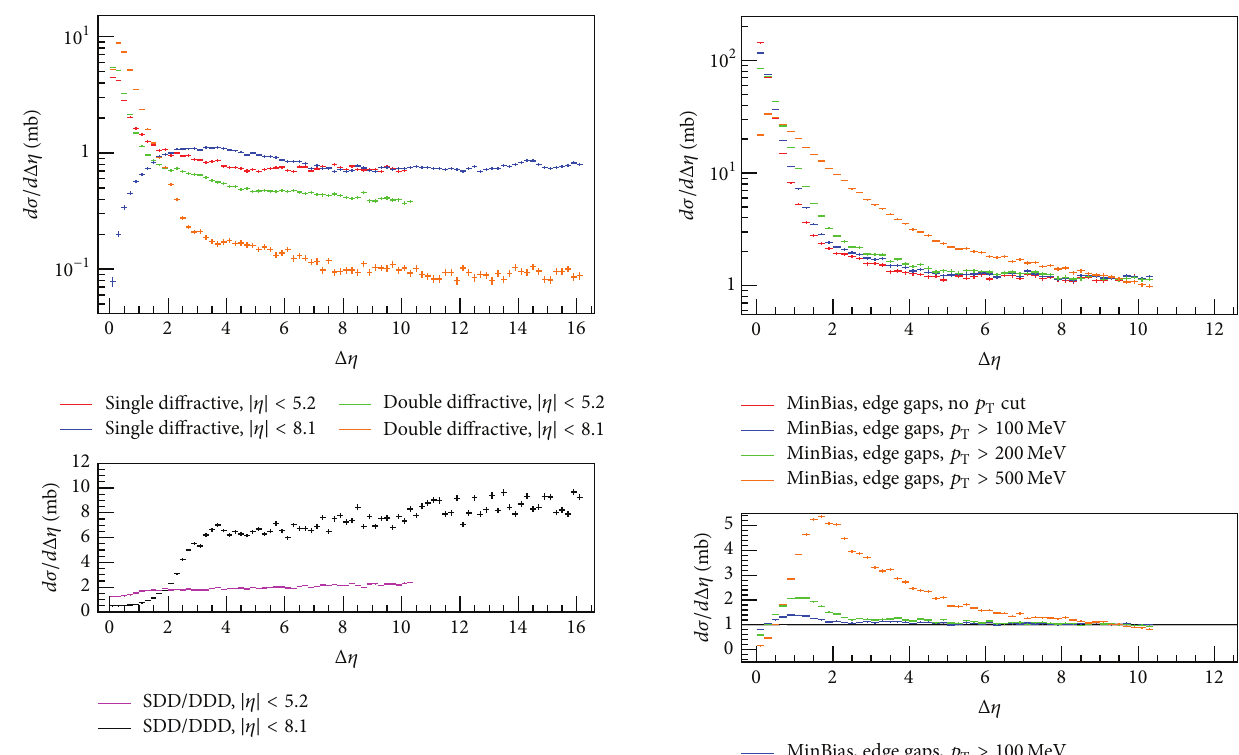
Figure 4: Large rapidity gap distribution for single and double diffractive dissociation events in the different detector rapidity acceptance. The gap is defined as an edge gap. Ratio of single to double diffractive dissociation events is given on the ratio plot. Figure 5: Large rapidity gap distribution for minimum bias events (SDD + DDD + ND). The gap is defined as an edge gap from all final state particles in |𝜂| < 5.2 . The “MinBias, edge gaps, no 𝑝 T cut” is used as a reference on the ratio plot.